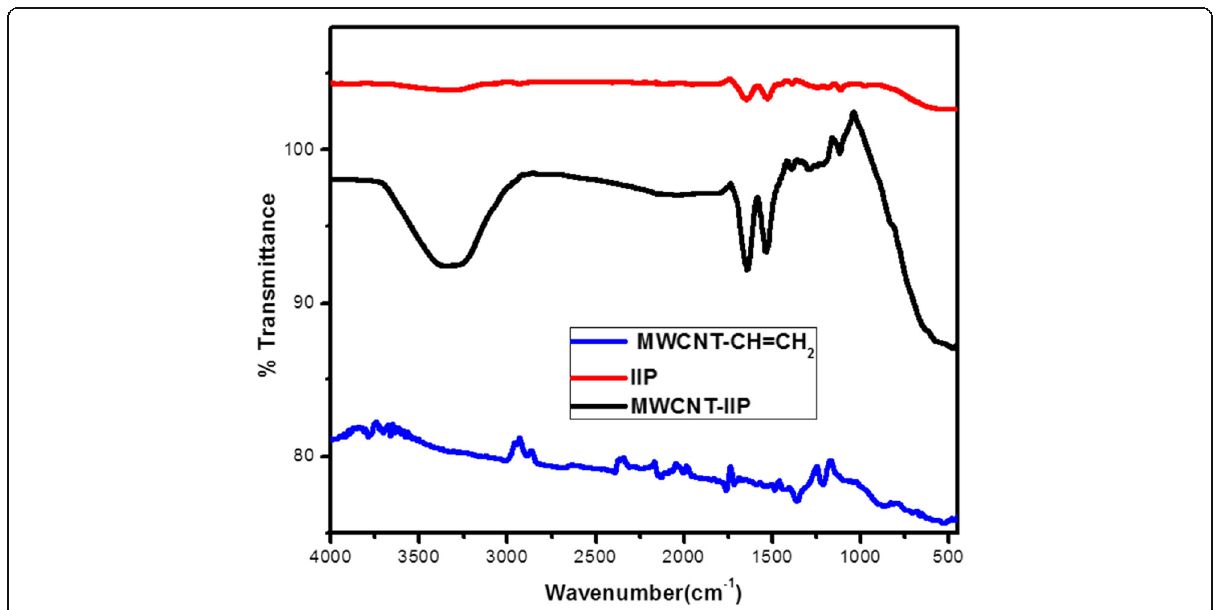
Fig. 1 FT-IR spectra of MWCNT-CH=CH2, IIP, and